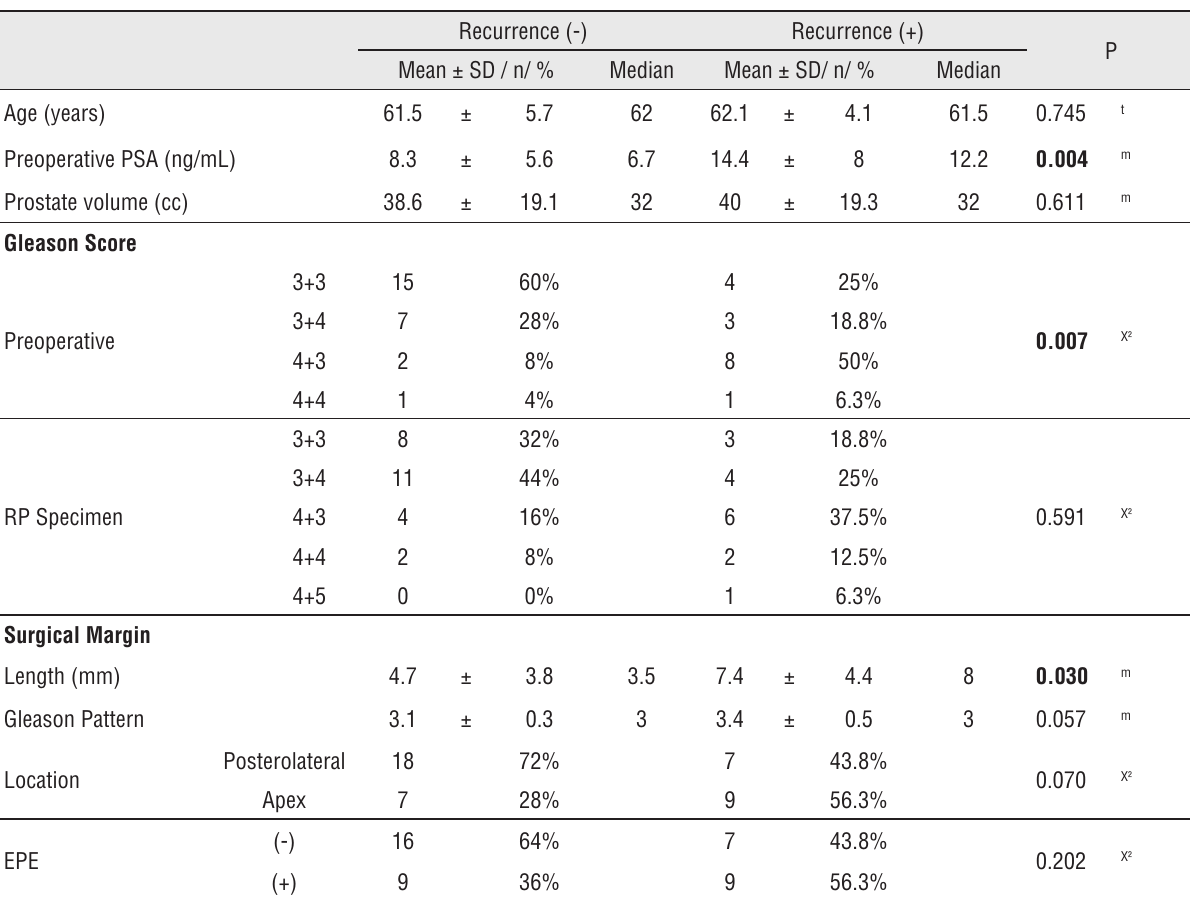
Table 2 - Recurrence and relationship with